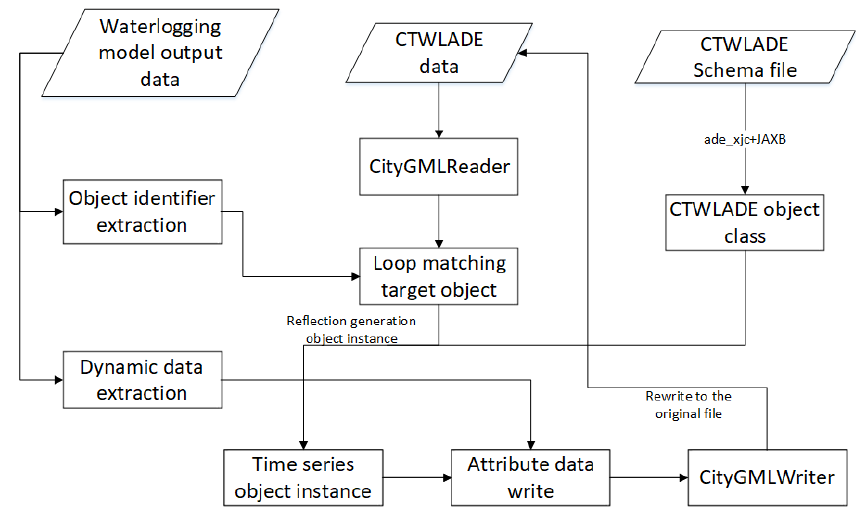
Figure 10. Integration process of dynamic time series data.